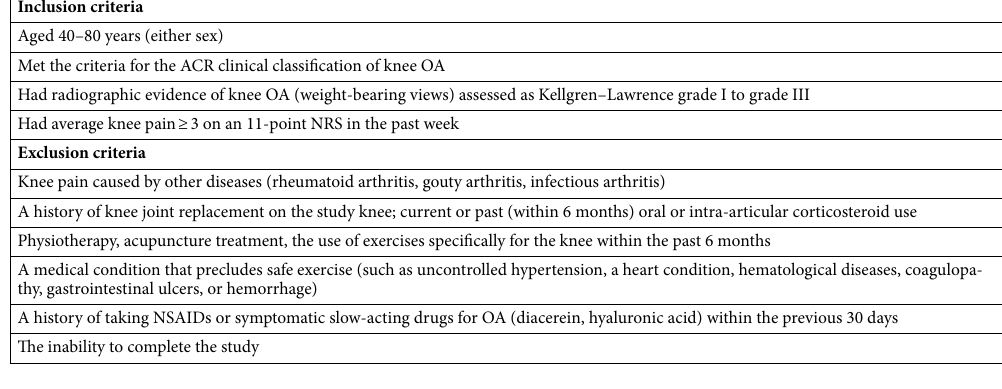
Table 1. Inclusion and exclusion criteria. ACR American College of Rheumatology, OA osteoarthritis, NRS Numerical Rating Scale, NSAIDs nonsteroidal anti-inflammatory